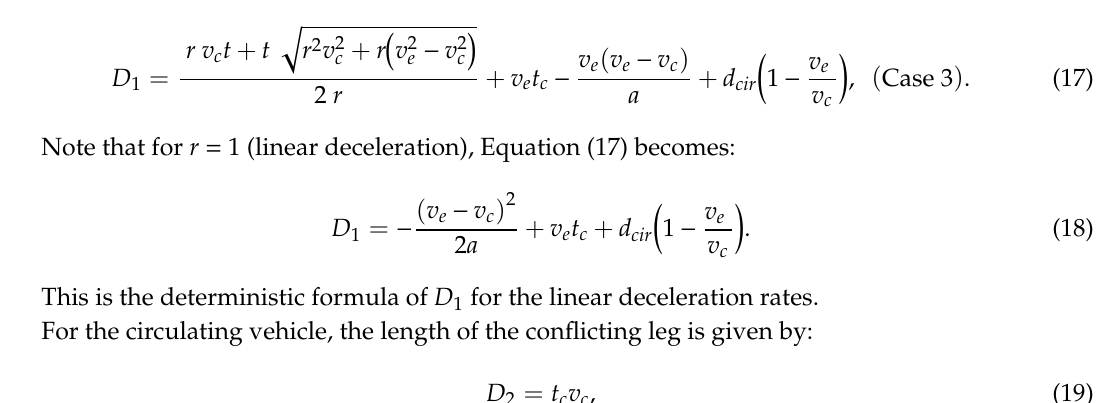
Table 2. E ff ect of the deceleration shape parameter on the sight distance D 1 (deterministic).